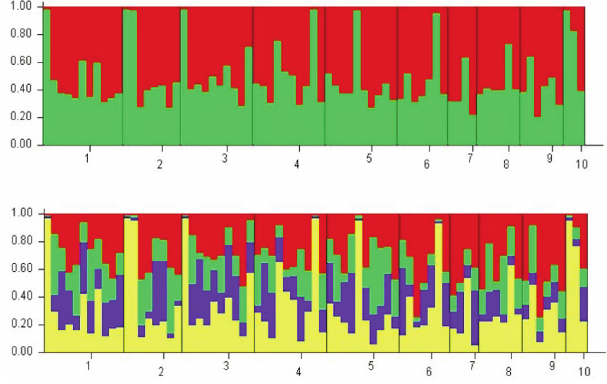
****Fig. 2 ­ Population structure of almond populations for K = 2 and K = 4, showing a high degree of genotypic admixture among individuals. On the horizontal axis, the following